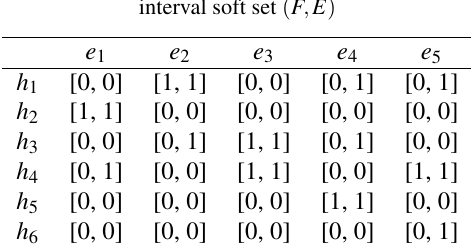
Table 1. I-type tabular representation of